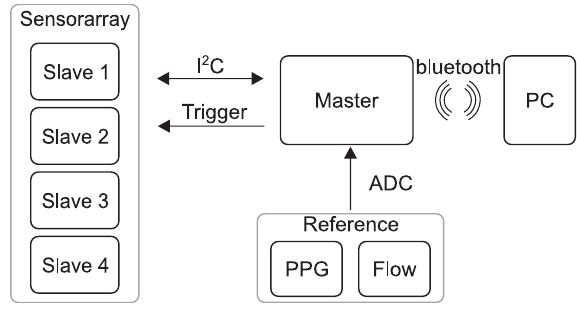
Figure 3. System overview of the MAIN (magnetic induction)